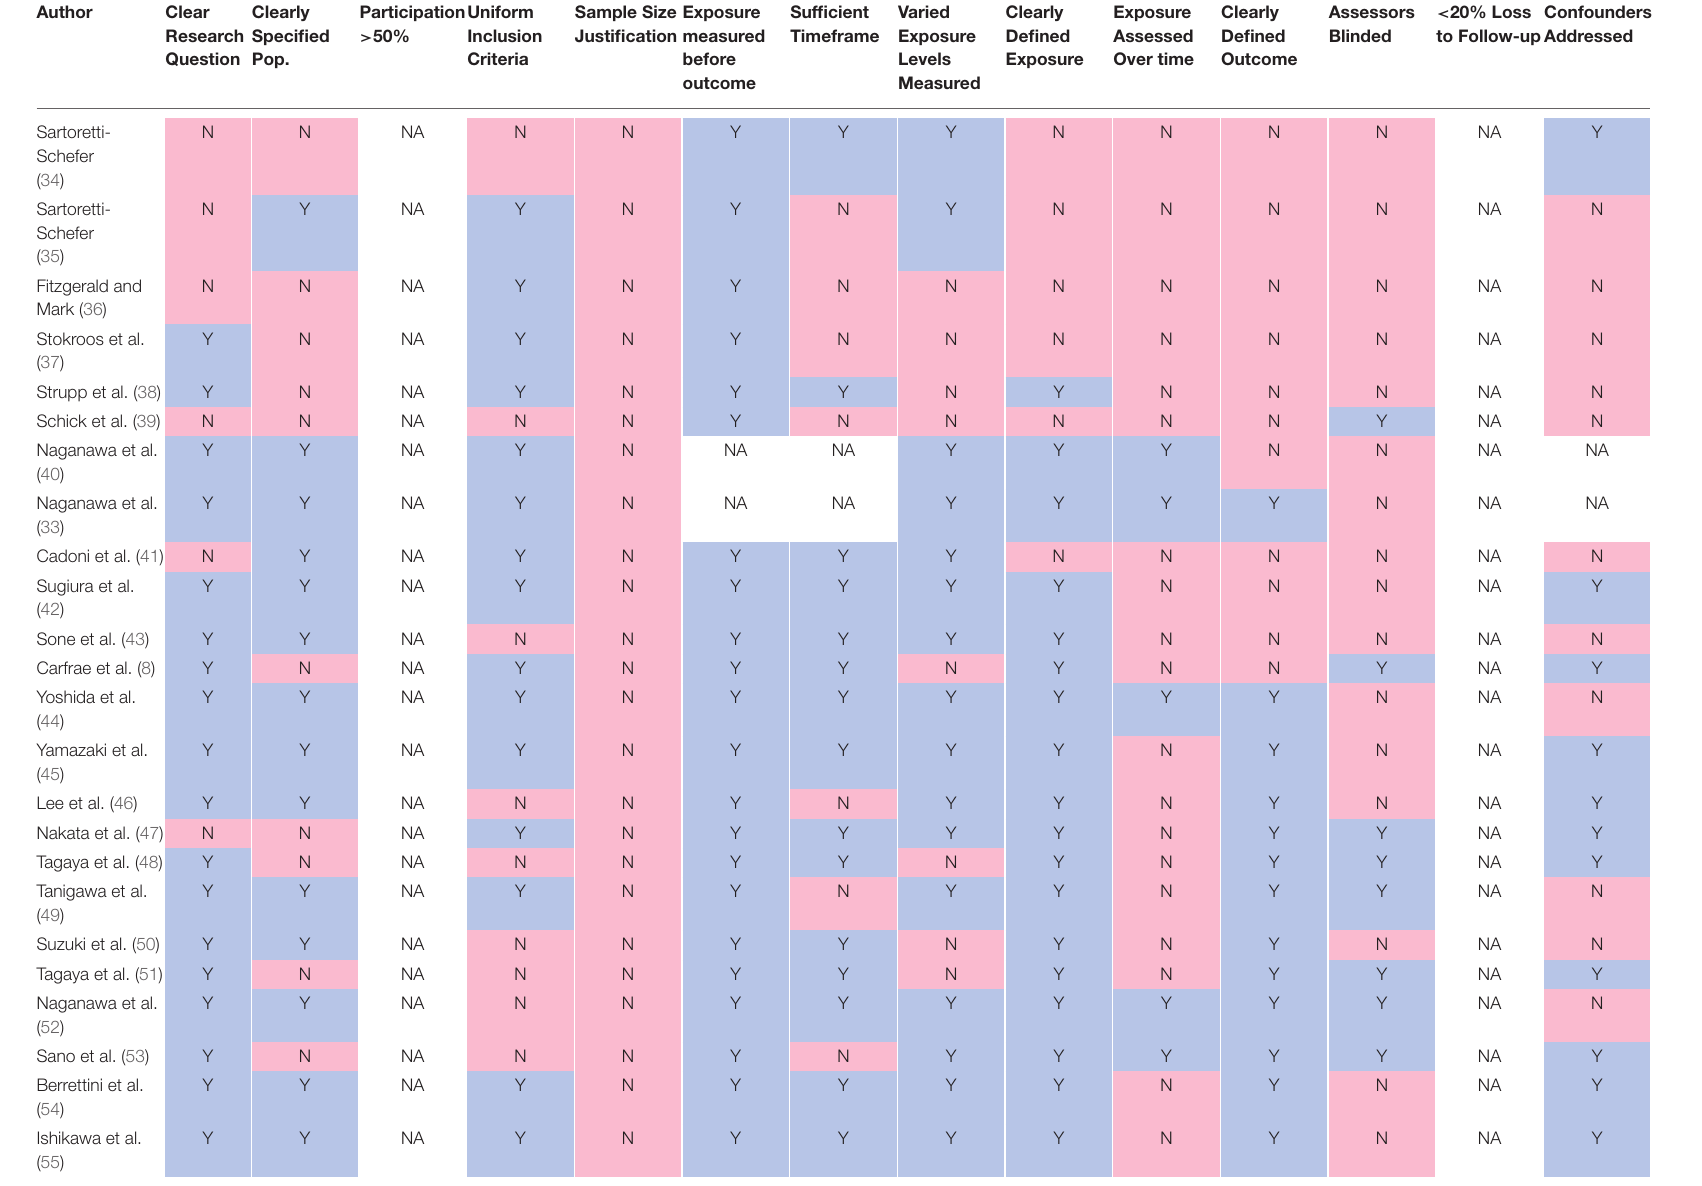
TABLE 2 | Quality assessment of included human studies with the NIH quality assessment